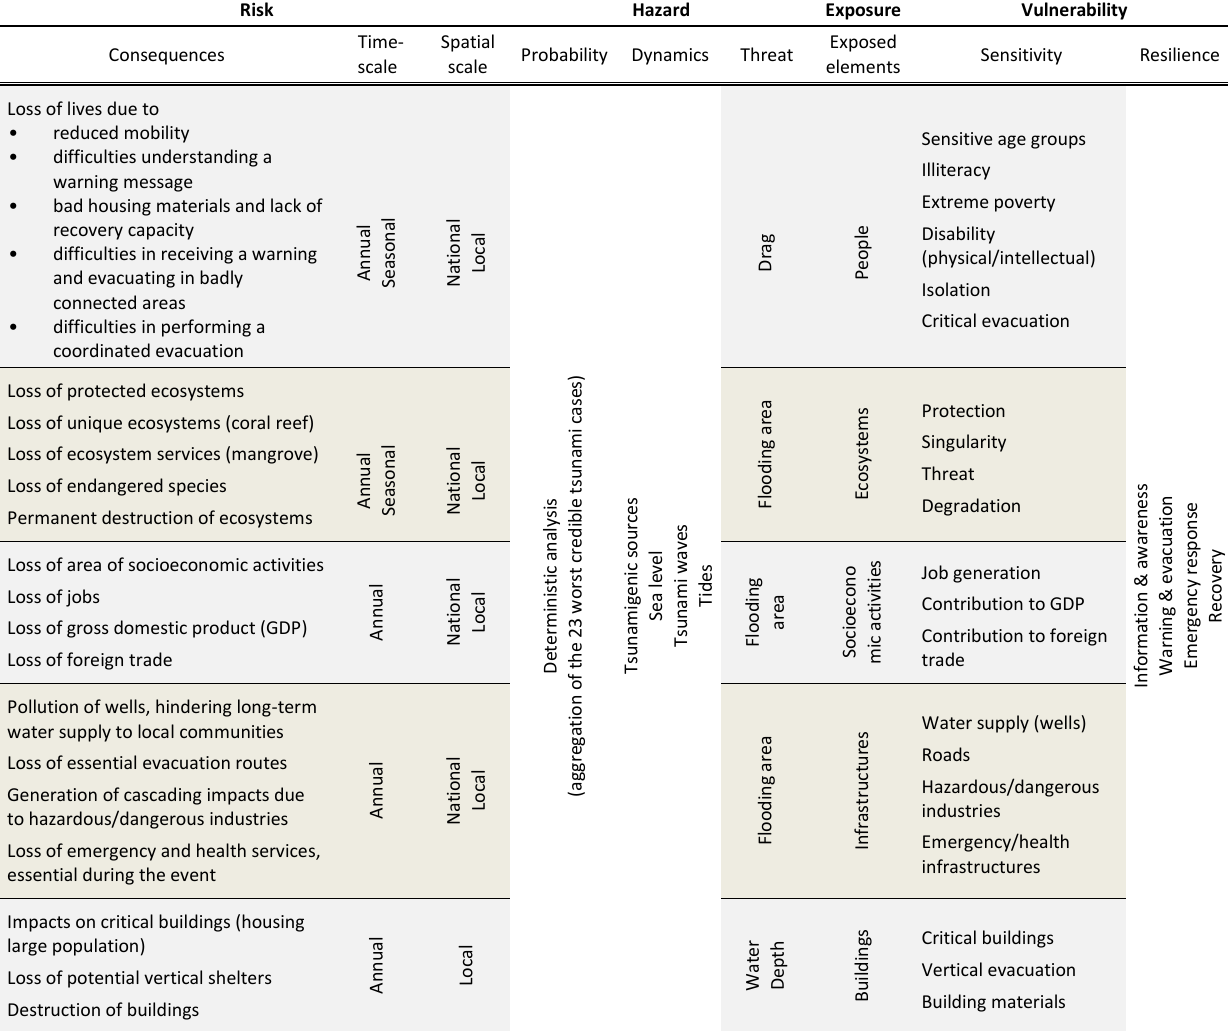
Table 1. Structure of the Tsunami Risk Assessment applied to El Salvador coastal area.